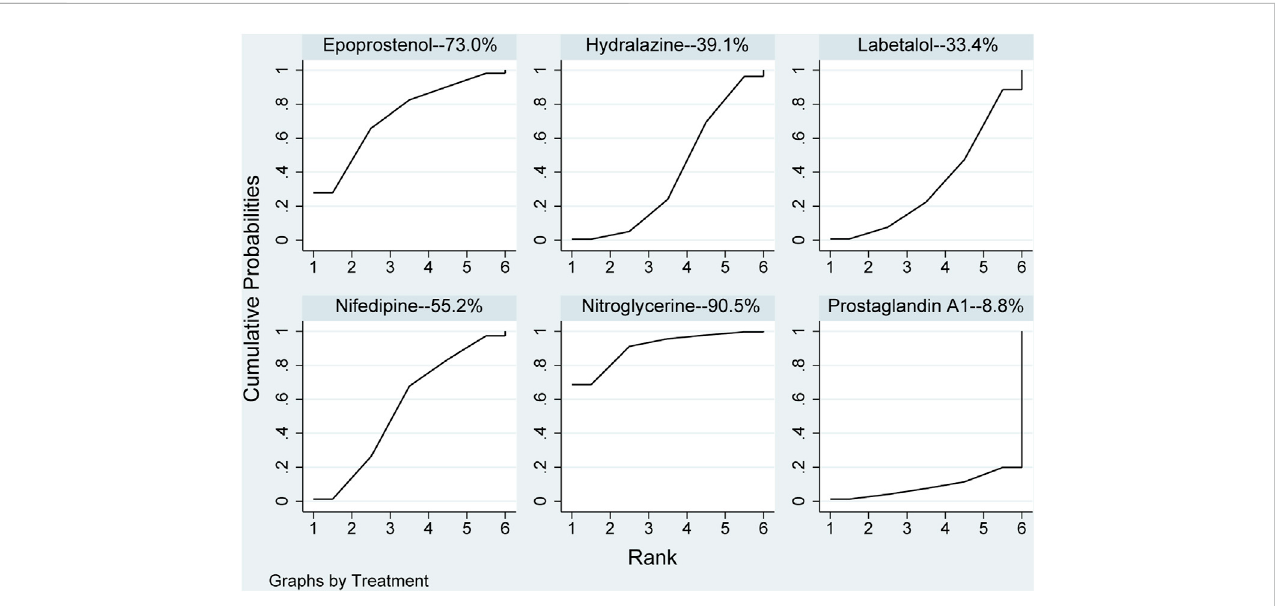
FIGURE 6 Ranking of all pharmaceuticals for systolic blood pressure. Note: The larger the area under the curve, the more likely it is to be the best intervention. SUCRA, Surface under the cumulative ranking.